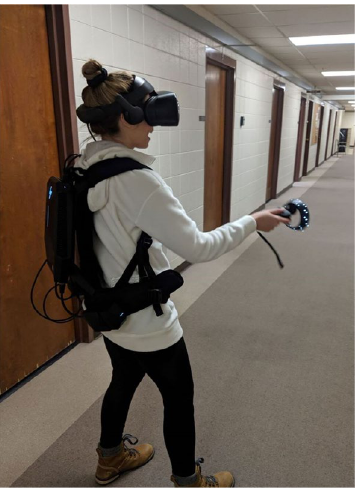
Figure 1. One of the authors wearing VR HMD and backpack computer.